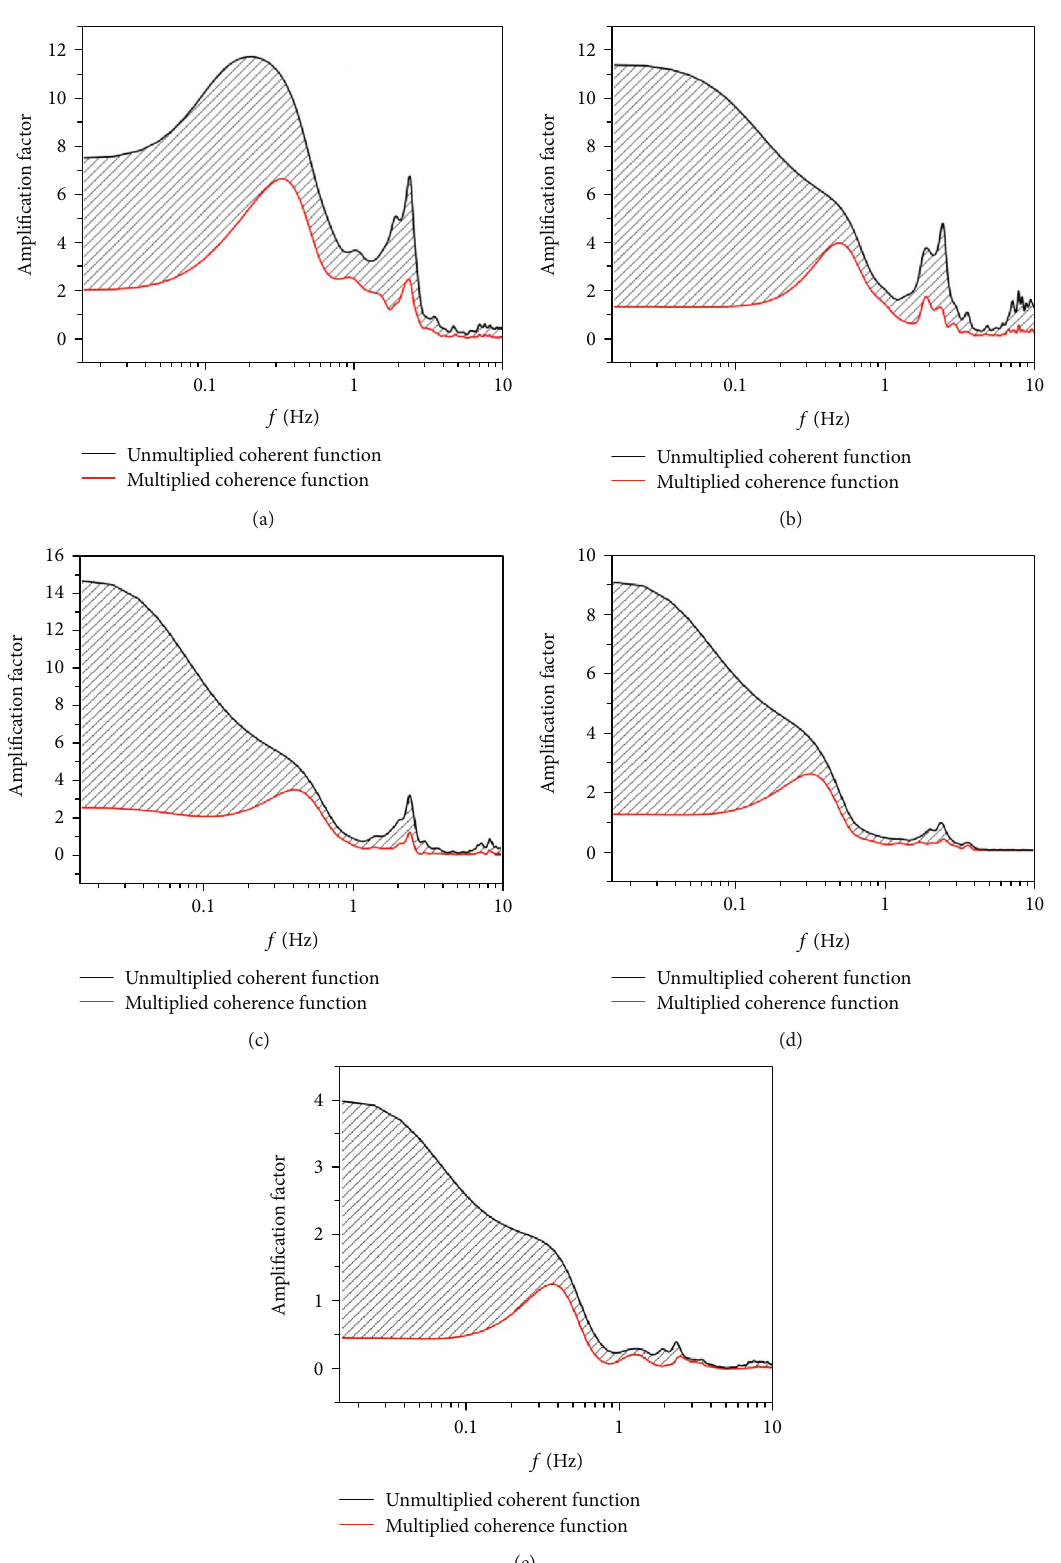
Figure 7: Ampli fi ed factor of the site response of the unmultiplied coherent function and the multiplied coherent function (model 1 for surface without water): (a) EL-1 situation, (b) EL-2 situation, (c) EL-3 situation, (d) EL-4 situation, and (e) EL-5